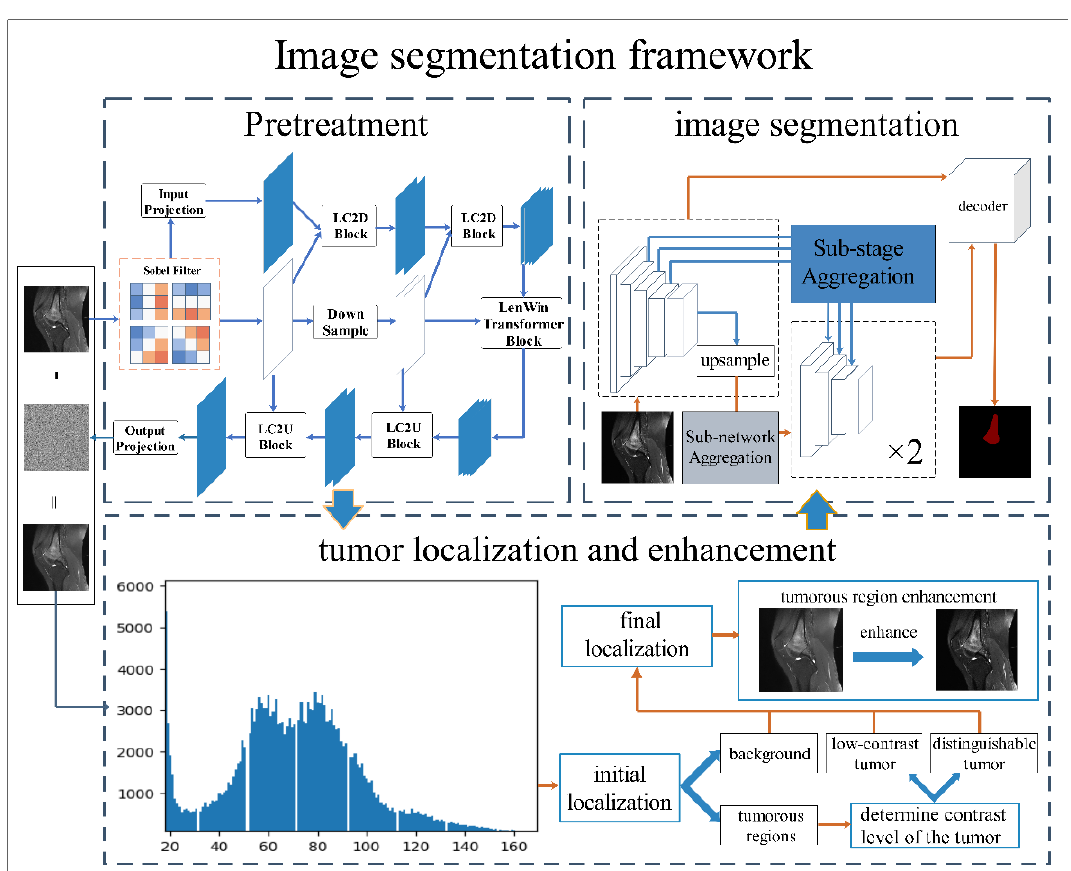
Figure 1. The overall structure of the method.